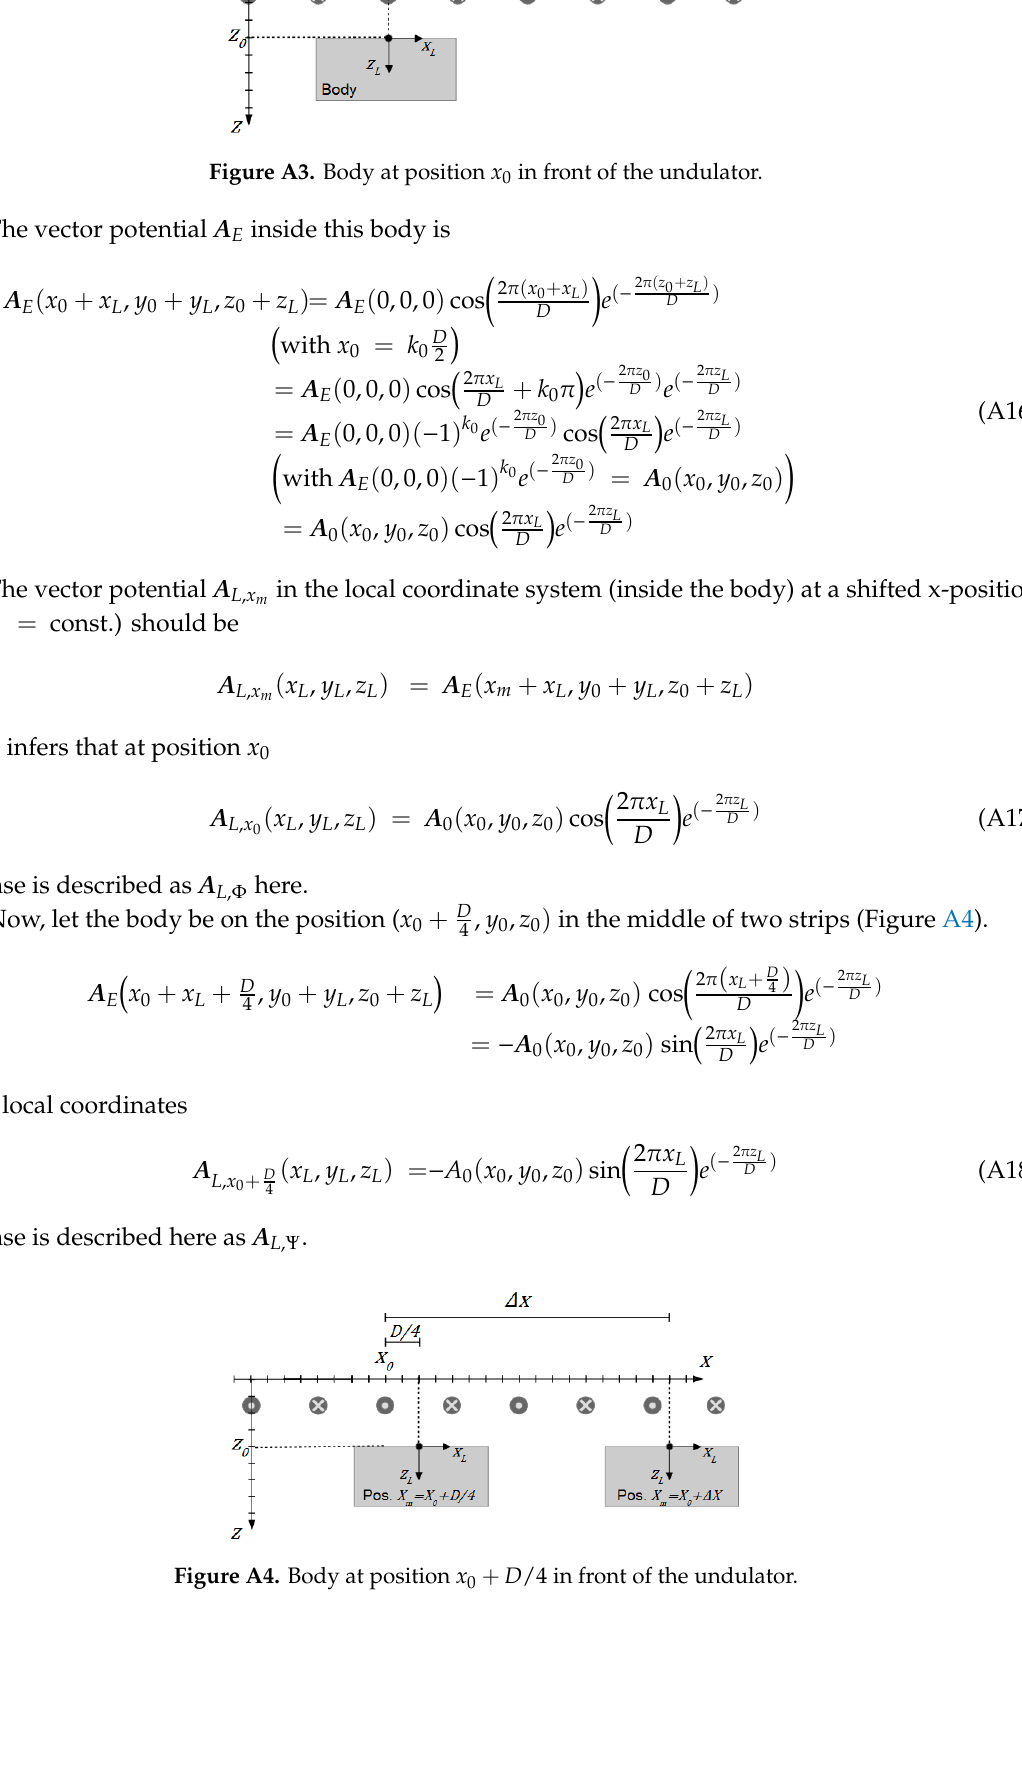
24 of 30 Figure A1. Calculated vector potential 𝐴 𝑦 of an undulator, sign suppressed. The x-coordinate extends in the horizontal direction and the z-coordinate in the vertical direction; ( a ) 5-wire undulator; ( b ) 11-wire undulator; ( c ) an undulator with 19 wires would behave as an almost infinite undulator with respect to the dimensions of the scanner and would virtually match Equation (2.2). Appendix D: Shortcut for the analysis of the forward problem The exciter vector potential 𝑨 𝐸 is assumed to be fixed. Thus, by moving the object in x-direction, only the vector potential 𝑨 𝐿 within the body changes, but the global vector potential of the transmitter remains constant in every point in space. The higher spatial frequency components decrease more strongly in the z-direction than the basic frequency; thus, only a sinusoidal vector potential exists in the measuring range (Appendix A). The primary vector potential 𝑨 𝐸 can be written as 𝑨 𝐸 (𝑥, 𝑦, 𝑧) = 𝑨 𝐸 (0,0,0) cos ( 2𝜋𝑥 𝐷 ) 𝑒 (− 2𝜋𝑧 𝐷 ) (A 15) The positions of the strips are 𝑘 𝐷 2 , 𝑘 𝜖 ℤ and all even 𝑘 have the same current direction, accordingly all odd 𝑘 are opposite. The body has its own local coordinate system ( 𝑥 𝐿 , 𝑦 𝐿 , 𝑧 𝐿 ). The x-position of the midpoint of the body is called 𝑥 𝑚 in the following (Figure A2).